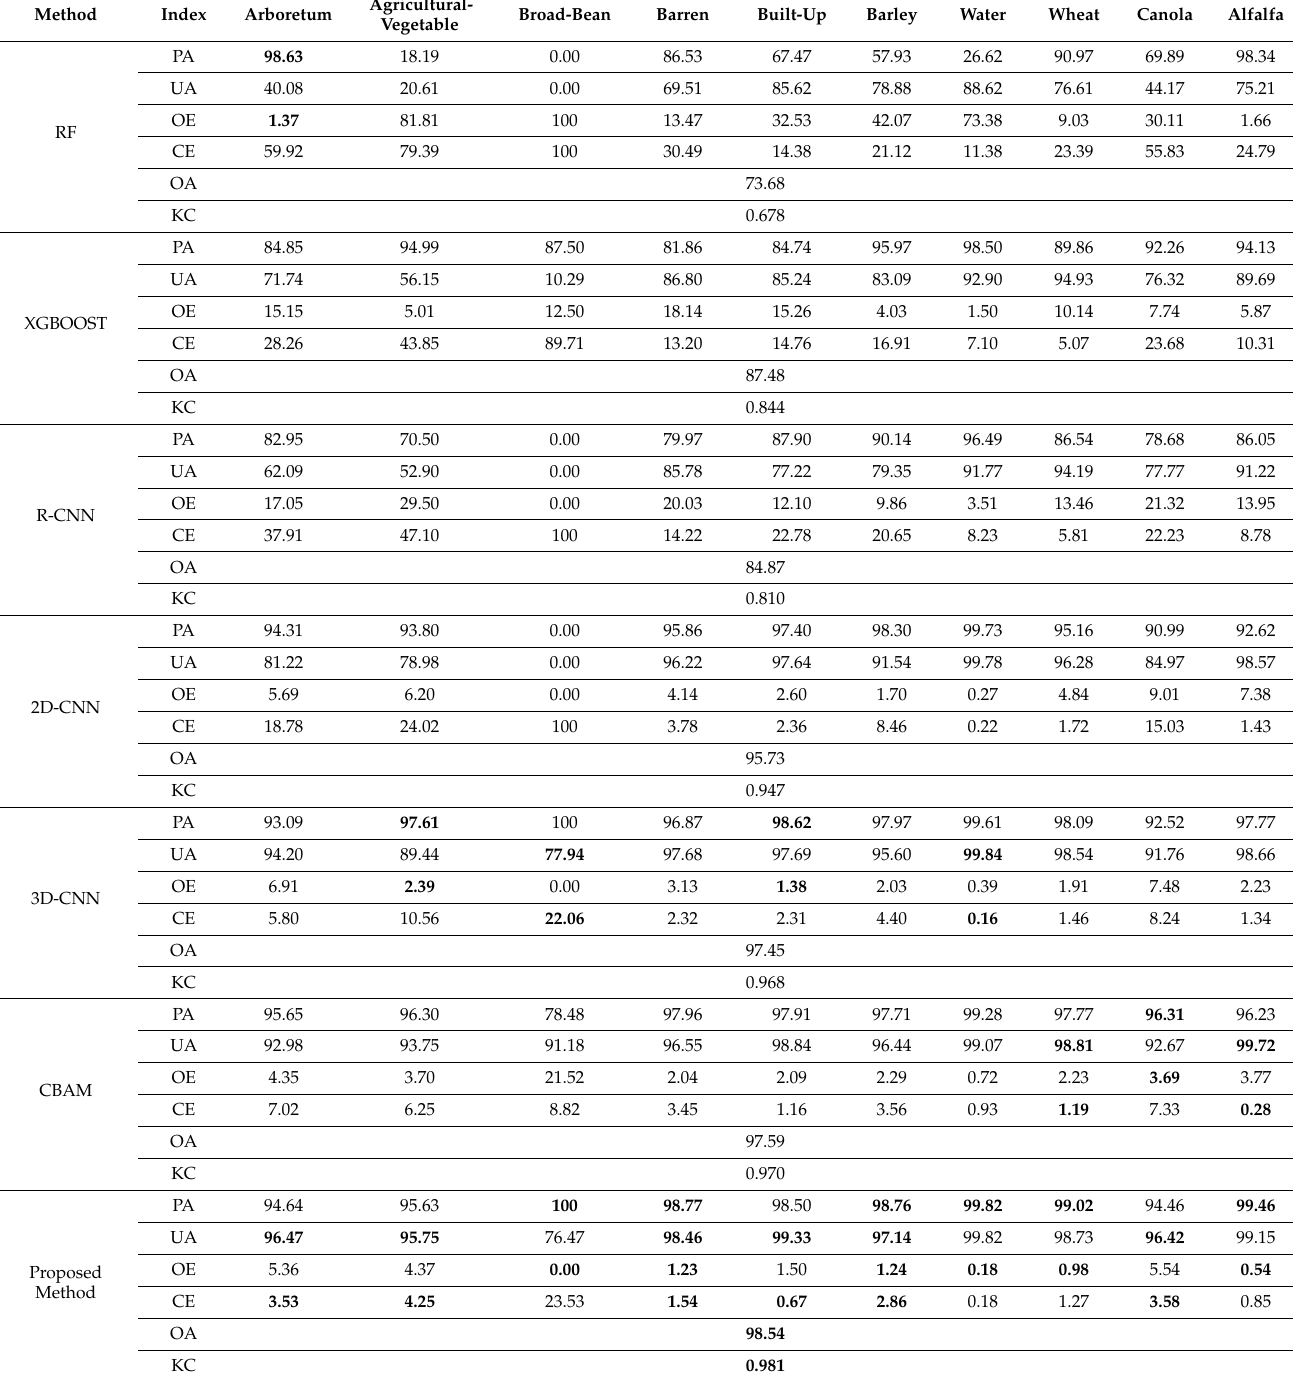
Table 4. Comparison of the accuracies of different classification algorithms for crop mapping. The bold values show the highest accuracies (OA: overall accuracy, KC: kappa coefficient, UA: user accuracy, PA: producer accuracy, OE: omission error, CE: commission error, RF: random forest, R-CNN: recurrent convolution neural network, CNN: convolution neural network, CBAM: convo- lutional block attention module, 2D: 2-dimensional, 3D: 3-dimensional). The bold values show the highest